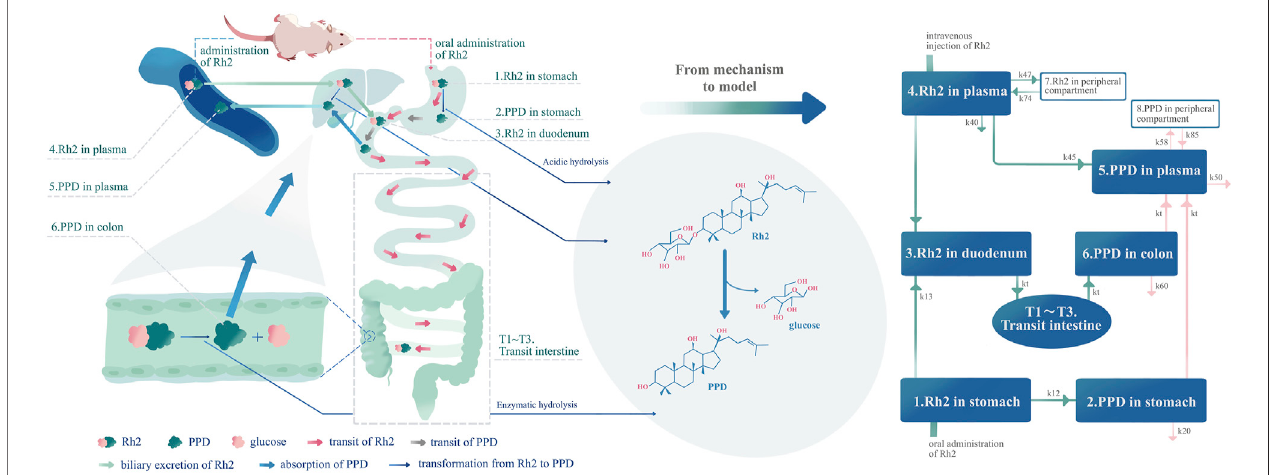
FIGURE1 | Developmentofthe pharmacokineticmodel accordingto themechanism ofthe deglycosylation kinetics ofRh2 and in vivo metabolite (PPD) kinetics in rats. The left part of this fi gure is the mechanism diagram corresponding to the structure of pharmacokinetic model (right part of the fi gure). Hydrolysis in the liver, transformation from Rh2 to PPD in the liver (k 45 ), route A in text article. Route A is assumed to exist since the PPD can be detected immediately after I.V. dosing of Rh2. Enzymatichydrolysis,transformationfromRh2toPPDbyglycosidehydrolasesfrommicro fl